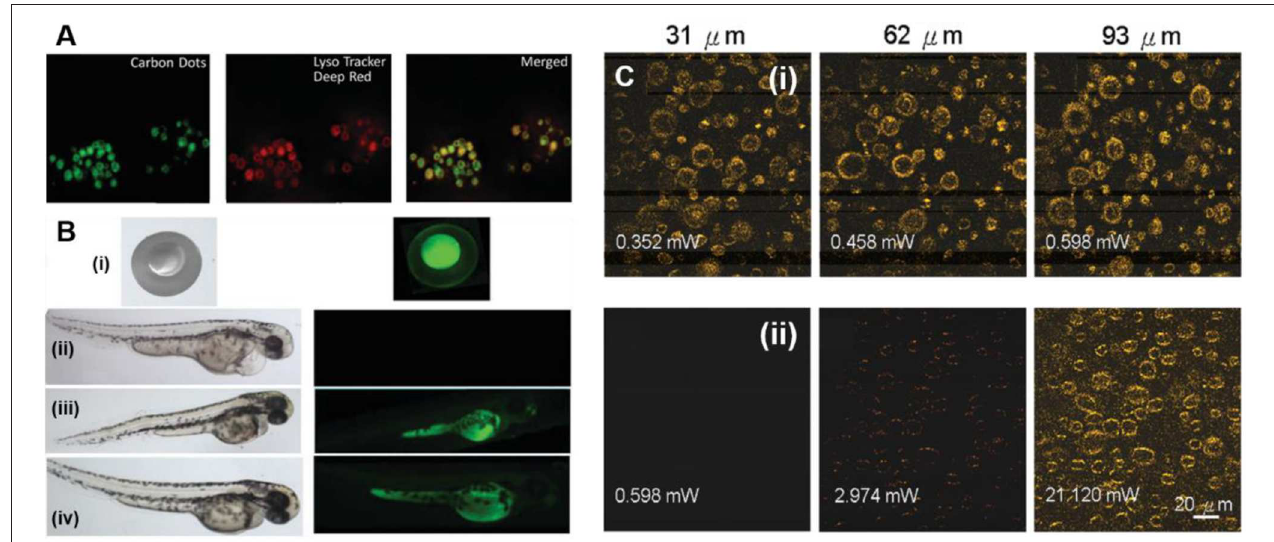
FIGURE 11 | (A) In vitro co-localization study using Lyso Tracker to monitor the internalization of the GQDs in RAW cells. (B) Bright-field (left) and FL images (right) of zebra fish embryos and larvae treated with GQD solution for 30min, and then imaging at different time-points (i) 1 hpf, (ii,iii) 72 hpf, and (iv) 96 hpf. (ii) the control; reproduced from Singh et al. (2019) with permission from the Royal Society of Chemistry. (C) Depth and laser power-dependent TPFL images of N-GQDs labeled (i) and unlabeled A431 cells (ii); reproduced from Wu et al., 2018) with permission from the Royal Society of